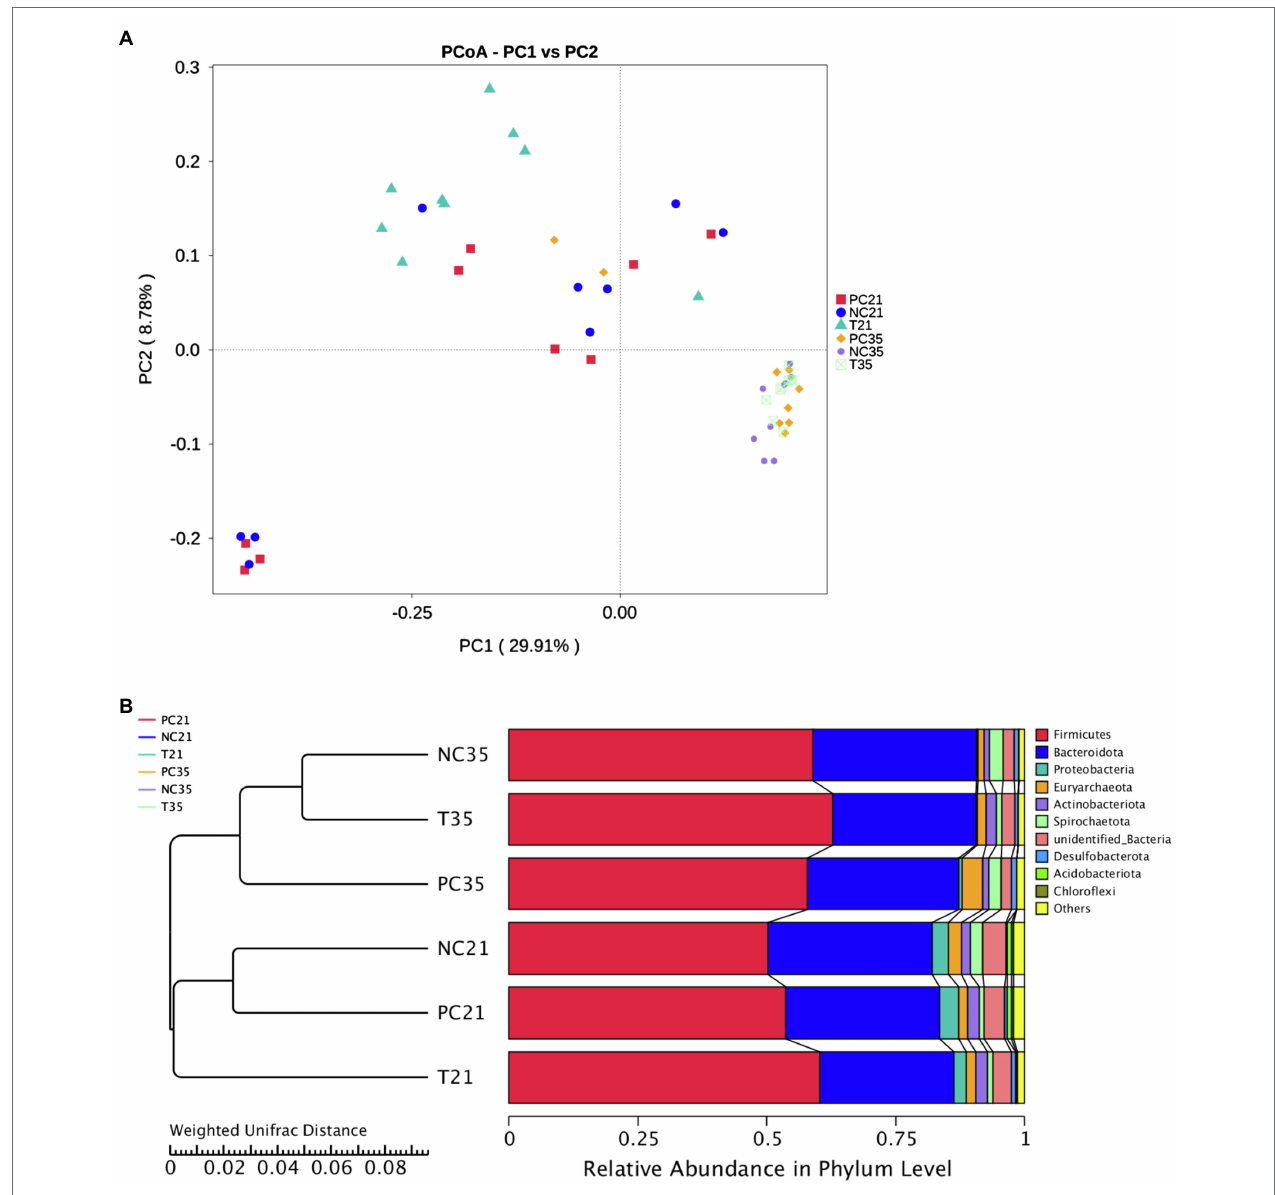
FIGURE 4 | Effects of Z. Tk and ZnO on the intestinal microbial diversity in weaned piglets in 21 and 35 days based on beta diversity analyses of principal coordinate analysis (A) and UPGMA clustering analysis (B) based on weighted UniFrac. Each of the nine samples is selected from each of the three groups of piglets, i.e., the positive control (PC), the negative control (NC), and the test groups, on days 21 and 35,